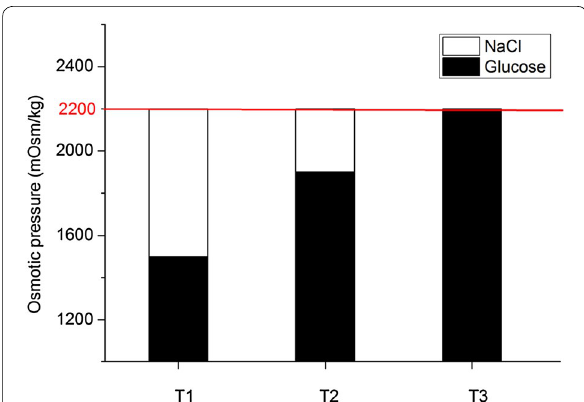
Fig. 11 Experimental design to investigate the physiological roles of glucose in seed culture of A. niger